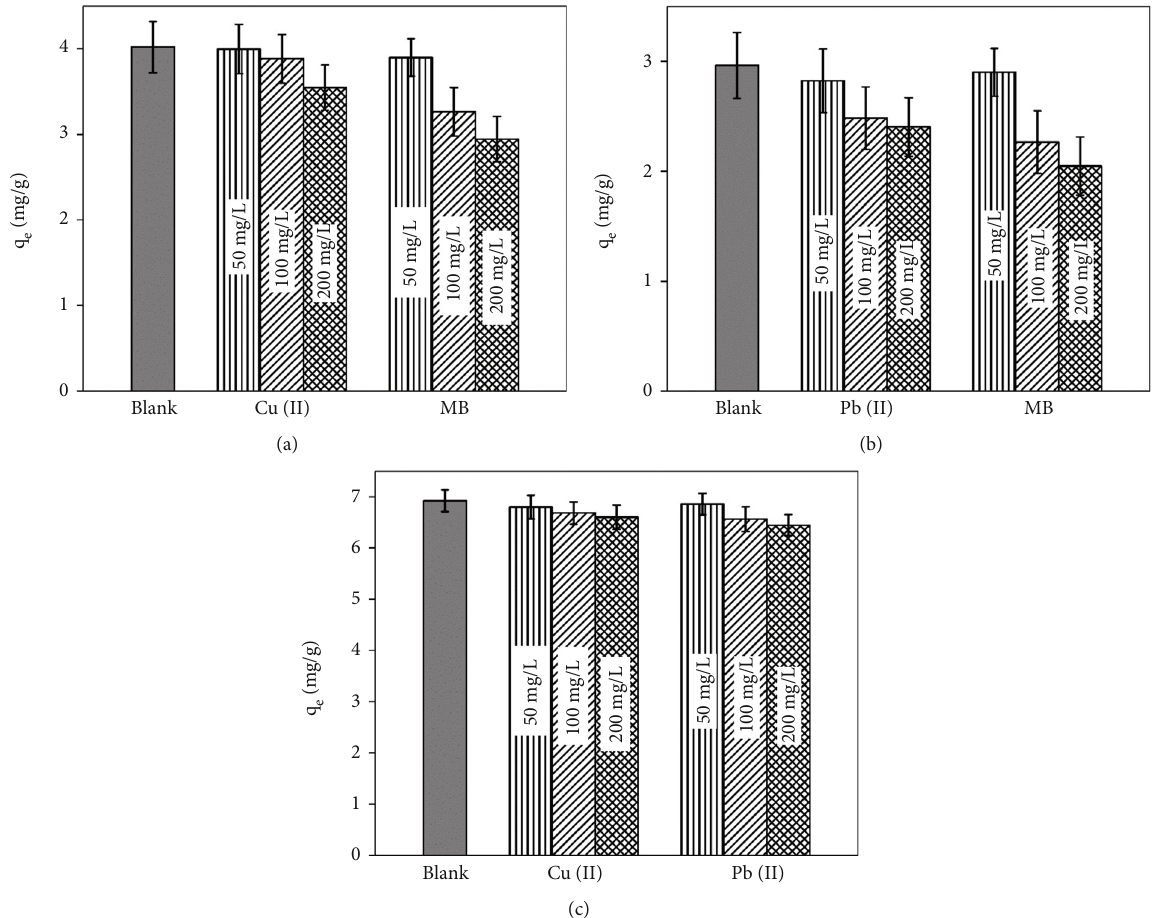
Figure 9: E ff ect of competing ions/molecules on the adsorption of (a) Pb(II), (b) Cu(II), and (c) MB onto pure fennel seeds (PFS) (system parameters: temperature = 298 K, working solution = 100 mg/L, contacttime = 120 min, and adsorbentmass = 10 mg